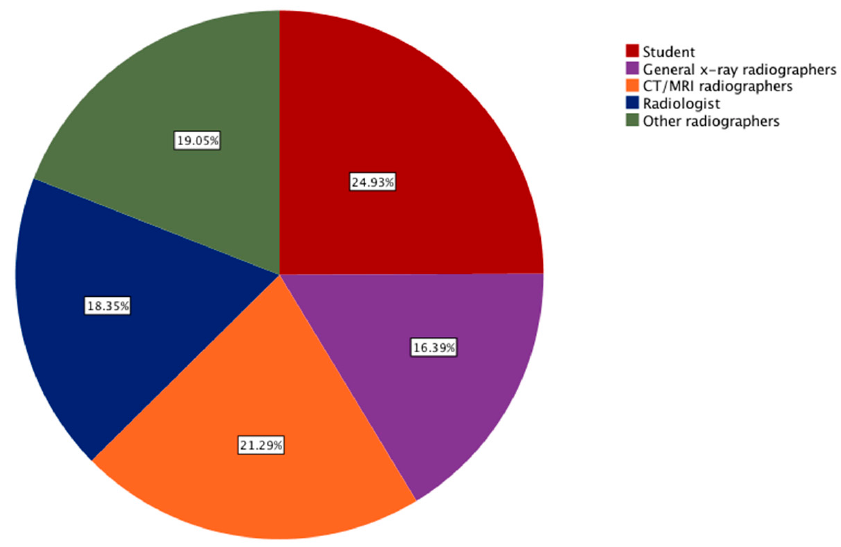
Figure 2. A pie graph showing the distribution of participants based on their professions.